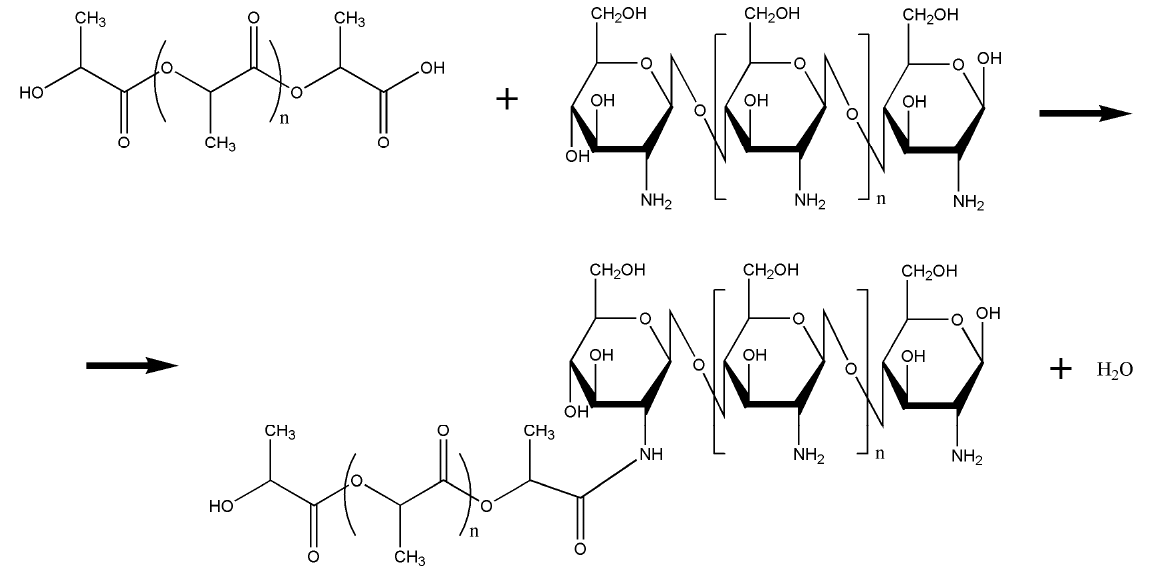
Figure 2. Scheme of the representation of chemical modification of chitosan with poly (lactic acid).